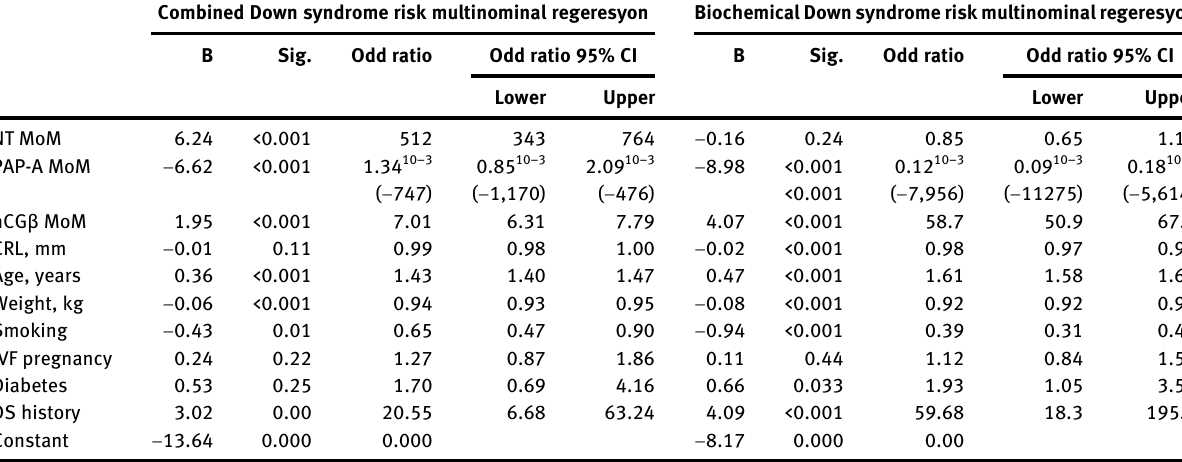
Table  : Multiple regression analysis results of factors affecting combined and biochemical risk analysis. All levels were expressed in multiples of the normal median (MOM) for NT, PAPP-A, free β